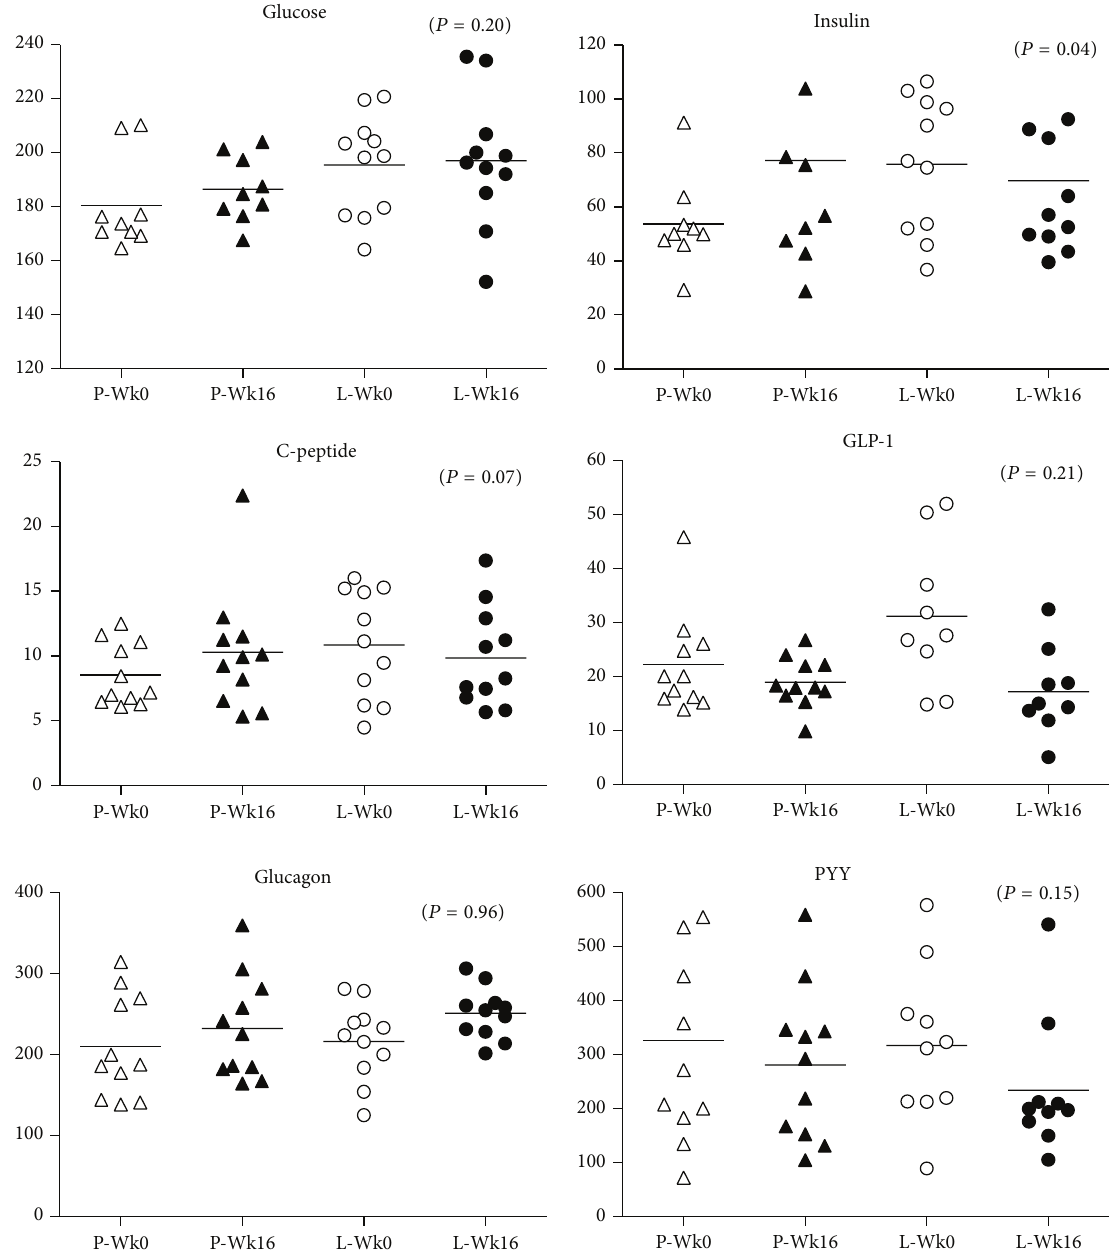
Figure 1: Levels of glucose, insulin, C-peptide, GLP-1, glucagon, and PYY. GLP-1 in placebo and leptin treated groups at weeks 0 and 16 (triangles, placebo group; circles, leptin group). Individual values and group mean (solid line) are